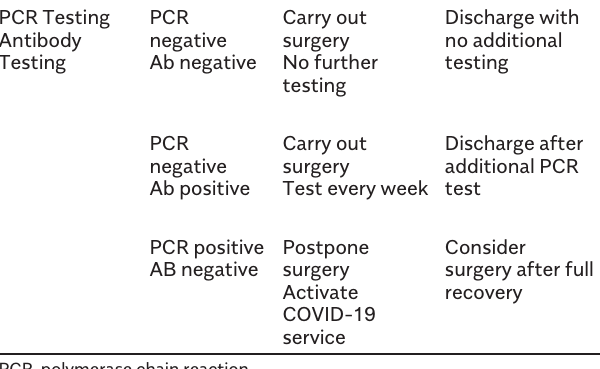
PCR, polymerase chain